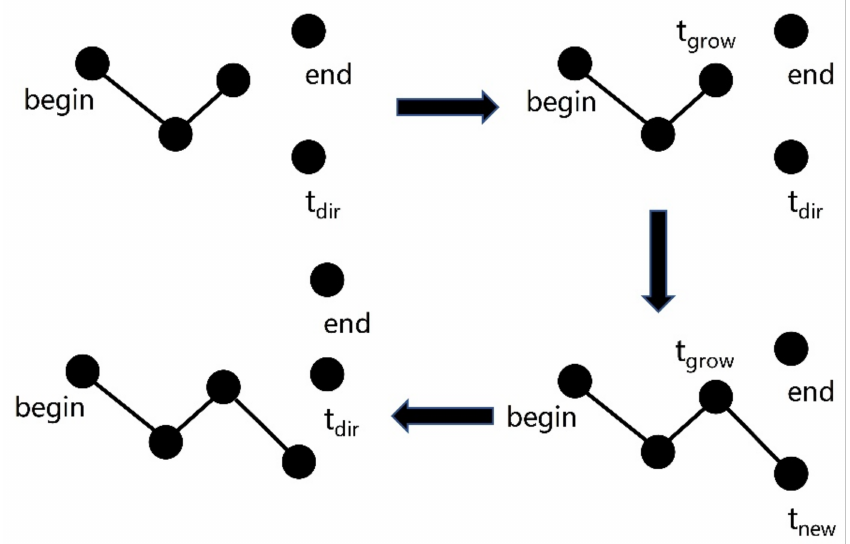
Figure 6. The growth process of the rapidly exploring random tree. (t dir is the random exploration direction point of the tree, t grow is the growth point of the tree, and t new is the next new node of the tree to be